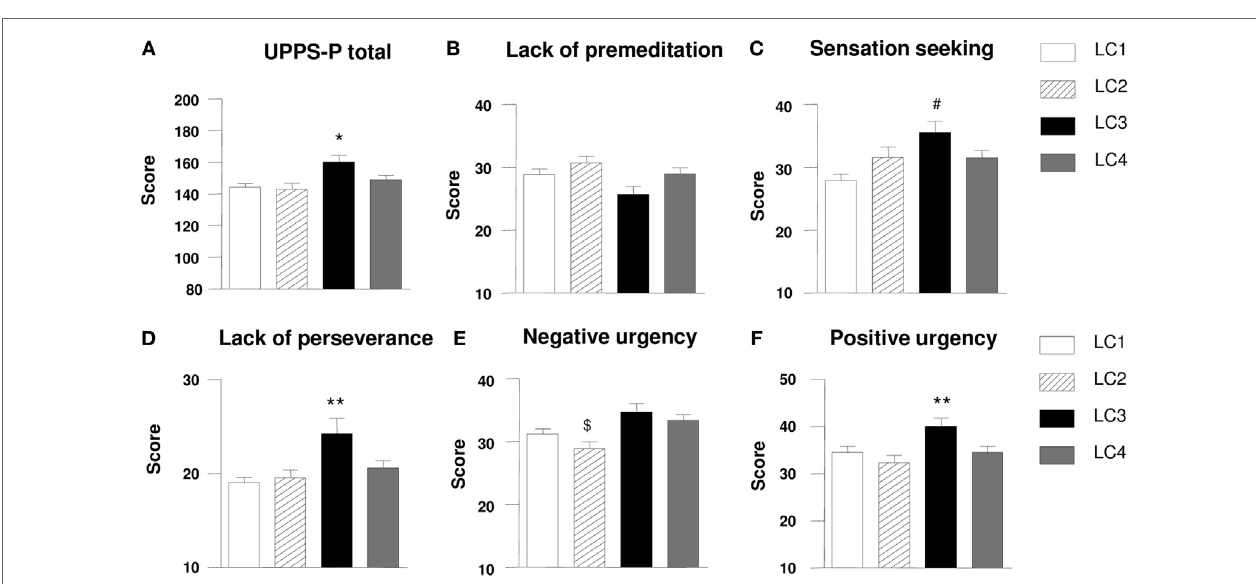
FigUre 3 | Scores of different impulsivity subscales according to latent classes (LC). LC3 patients showed a greater level of impulsivity than other classes (a) ; There were no differences between LCs in lack of premeditation (b) ; LC3 patients showed a greater level of sensation seeking than other classes (c) ; LC3 patients showed a greater level of lack of perseverance than other classes (D) ; LC2 patients showed a lower negative urgency in comparison to other classes (e) ; LC3 patients showed a greater level of positive urgency than other classes (F) . Data are expressed as the mean ± SEM. Post hoc Newman–Keuls comparisons: difference vs. the other three groups: * p ≤ 0.05; * *p ≤ 0.01; difference vs. LC1: # p ≤ 0.01; difference vs. LC3 and LC4: $ p ≤